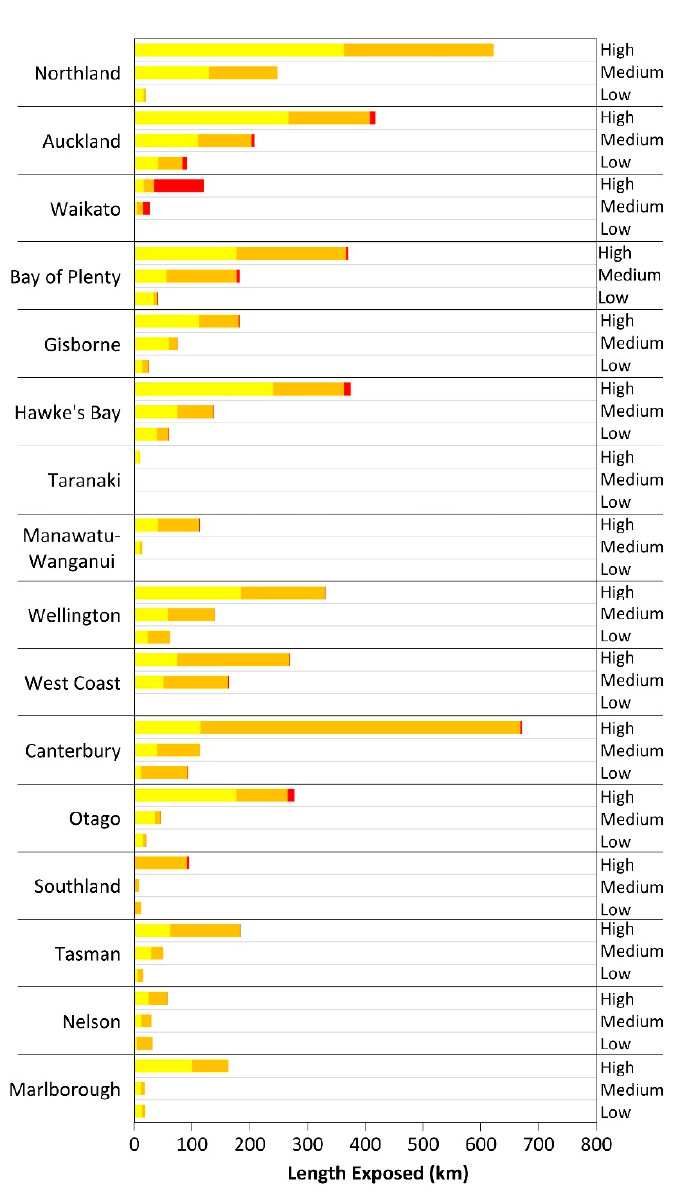
Figure 7. Regional road exposure within ‘red’, ‘orange’ and ‘yellow’ tsunami evacuation zones for ‘high’ (>10,000 vehicles/day), ‘medium’ (>3000 vehicles/day) and 'low’ (<3000 vehicles/day) traffic volume, as defined in Table S2.